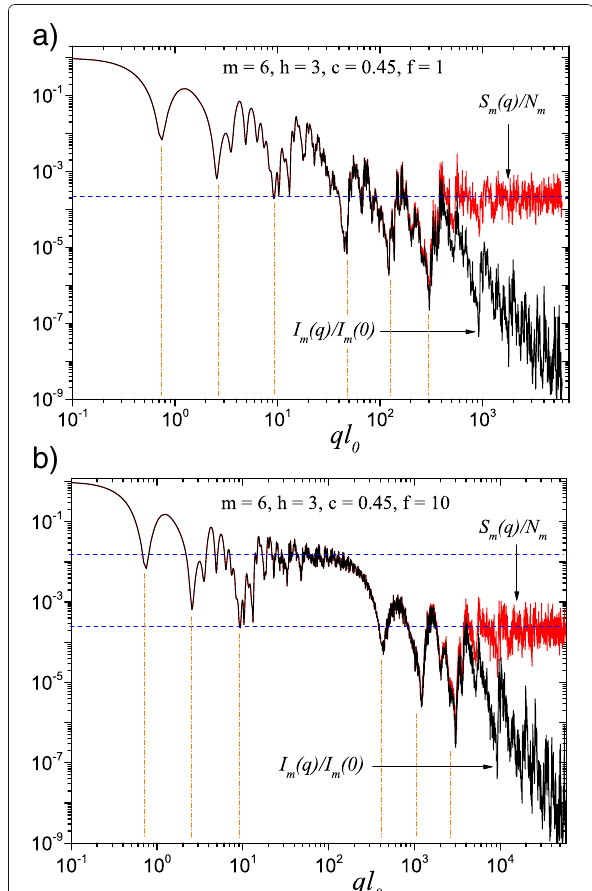
Fig. 2 (Color online) A comparison between scattering intensity given by Eq. (22) ( blackcurves ) and structure factor given by Eq. (24) ( redcurves ) at m = 6 and averaged over orientations according to Eq. (25). Here, h = 3 (i.e., scaling factor is kept constant for three consecutive iterations), while the basic shape in calculating the scattering intensity is a square of edge size l 0 : a l 0 = l in ; b l 0 = l in / f (with f = 10). When f (cid:10)= 1, a plateau of constant intensity appears between the two generalized power-law decays (Fig. 2b). Horizontal lines denote the asymptote of the structure factor (cid:11) 1 / N m , while the minima positions are estimated according to Eq.